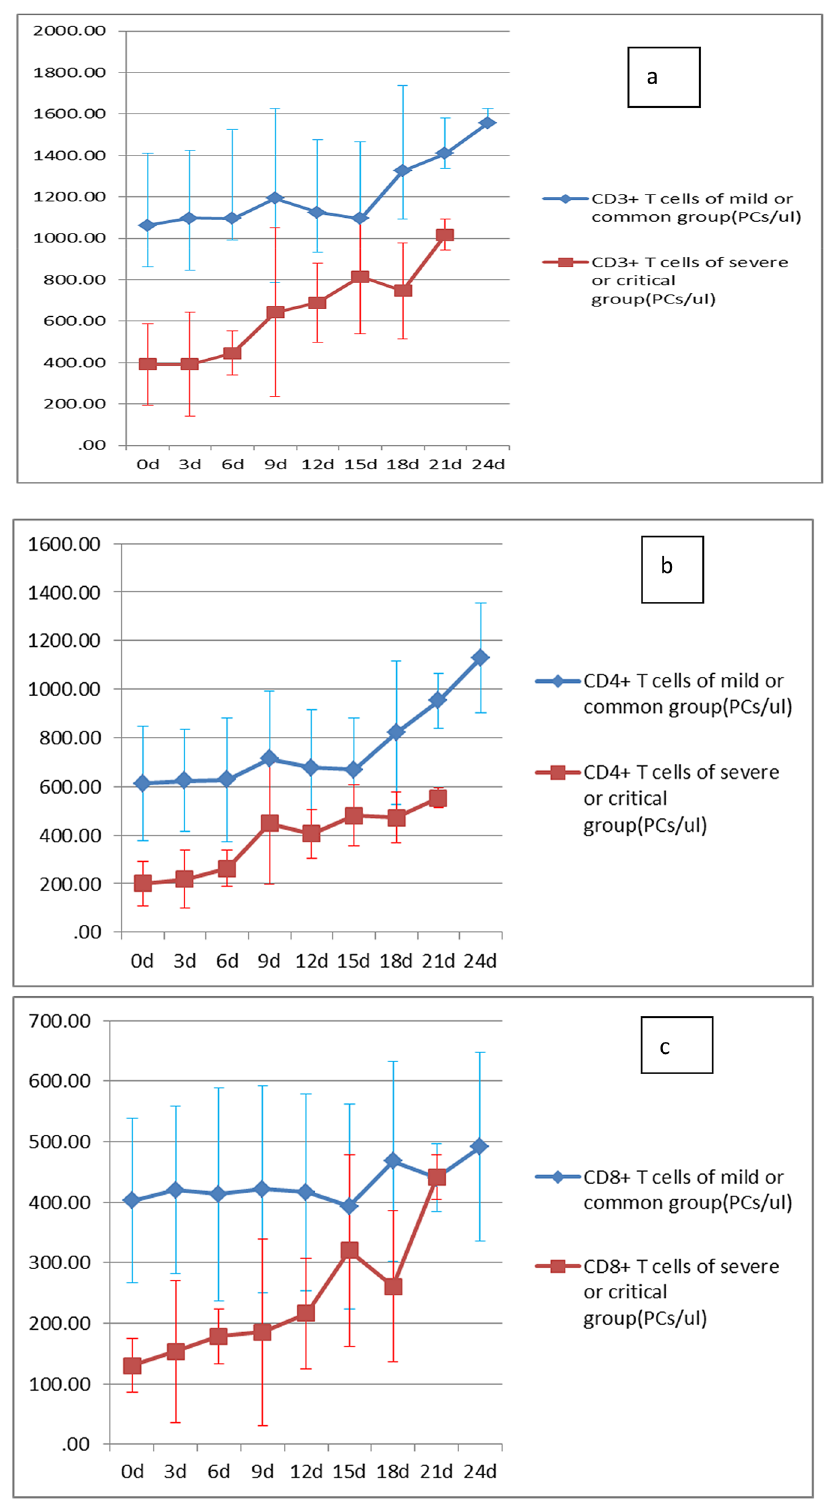
Figure 1. T-lymphocyte subsets dynamic changes of in training set: dynamic changes of CD3 + T cells (a), dynamic changes of CD4 + T cells (b), dynamic changes of CD8 + T cells